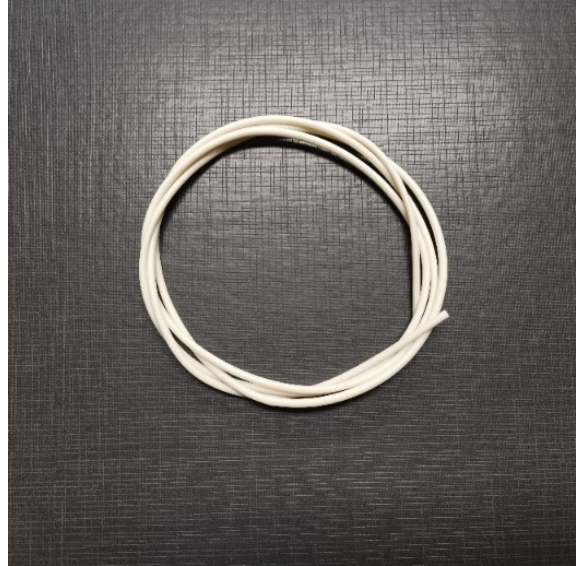
Figure 8. Extruded filament of ENR-50/PCL at 50/50.